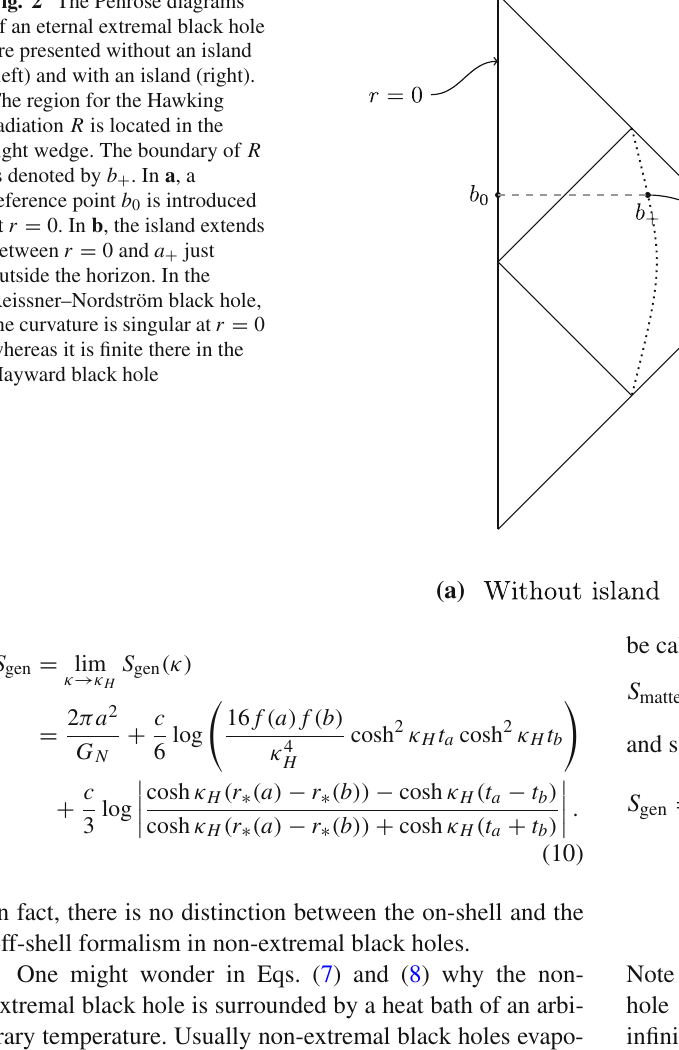
Fig. 2 The Penrose diagrams of an eternal extremal black hole are presented without an island (left) and with an island (right). The region for the Hawking radiation R is located in the right wedge. The boundary of R is denoted by b + . In a , a reference point b 0 is introduced at r = 0. In b , the island extends between r = 0 and a + just outside the horizon. In the Reissner–Nordström black hole, the curvature is singular at r = 0 whereas it is finite there in the Hayward black